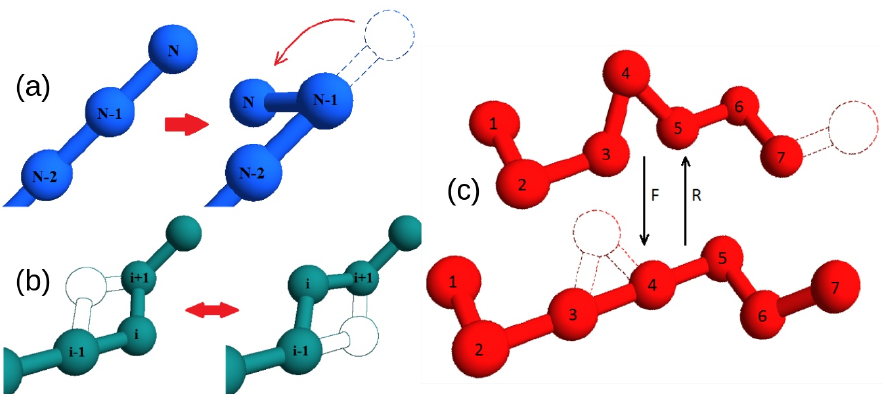
Figure 5. Illustration of the types of moves used in the simulations: ( a ) end-flip (frequency P = 2/19, the figure illustrates the random choice at the end with site N ), ( b ) crankshaft or internal flip ( P = 16/19), ( c ) reptation ( P = 1/19). In reptation, to satisfy detailed balance, the frequency of attempted moves in the two directions satisfy W R = 3 W F (“F” and “R” following the notation in the figure) because there are 12 possible points for the added end vs only 4 internal sites for the added corner. The internal flip is in one out of the 4 possible sites if the corner is of 60 ◦ or 90 ◦ , while only two sites are allowed when the corner is 120 ◦ . All attempted moves are then validated with self-avoidance constraints and eventually accepted with a Metropolis